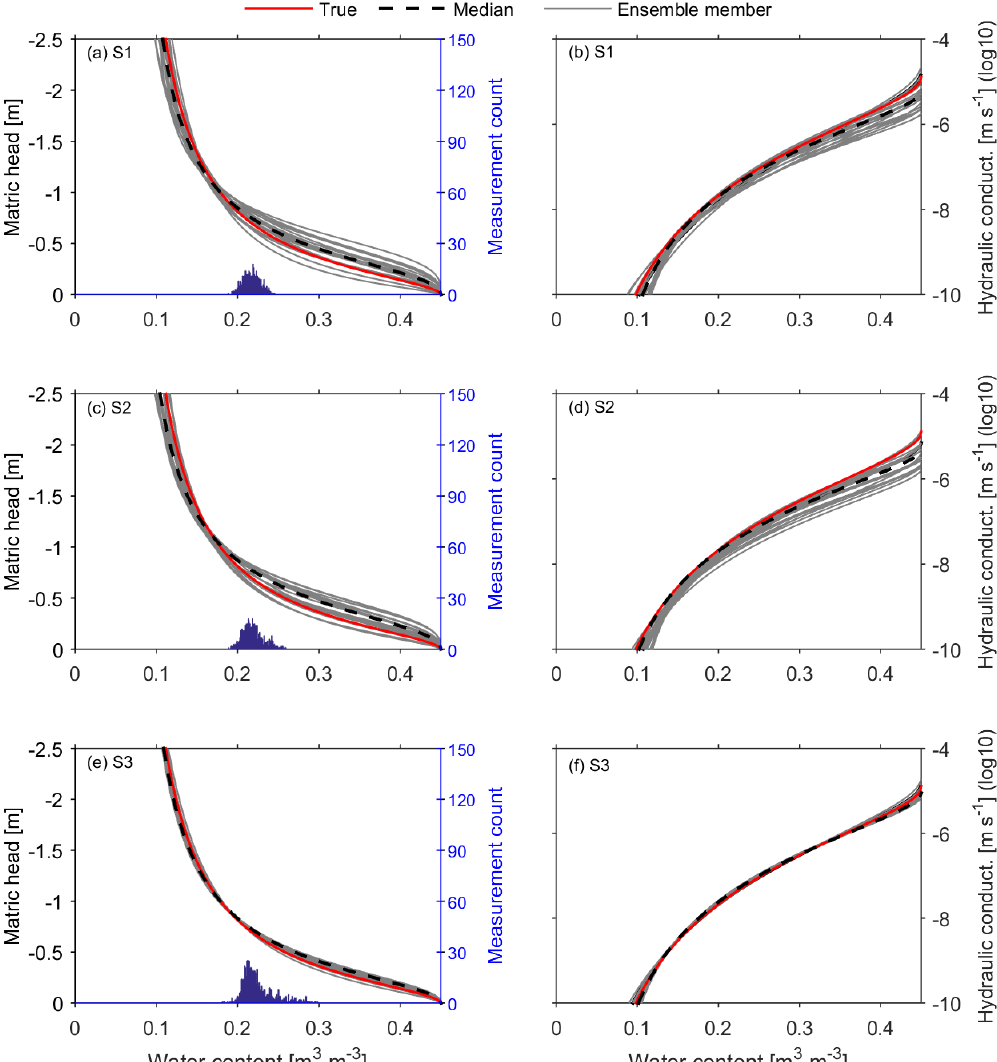
Figure 7. Effects of the slope gradient on the performance of the proposed approach. The top, middle and bottom panels compare the results for the soil architectures in Fig. 6. Similar to the lower panel of Fig. 4 for the synthetic study, the true parameter set is shown together with the 20 best ensemble members and the median of these parameter sets. The uncertainty of the resulting hydraulic properties decreases along with the sequentially increase in the slope gradient and water content range of the histograms from S1 to